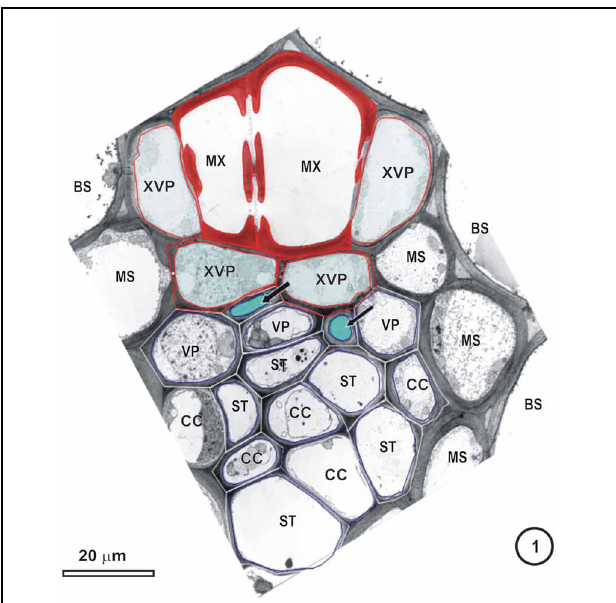
FIGURE 1 | Transmission electron micrograph of a large intermediate vascular bundle in the rice leaf blade surrounded by a parenchymatous bundle sheath (BS). The mestome sheath (MS) is only associated with the phloem pole of this vascular bundle. Metaxylem vessels (MX, red cell walls) are associated with two xylem vascular parenchyma cells (XVP, walls outlined in red and with a pale blue fill). Two late-formed, thick-walled metaphloem sieve tubes (unlabeled arrows and blue fill) abut XVPs. The early metaphloem (outlined in white) contains thin-walled sieve tubes (ST) associated with companion cells (CC) and several parenchyma cells (VP).